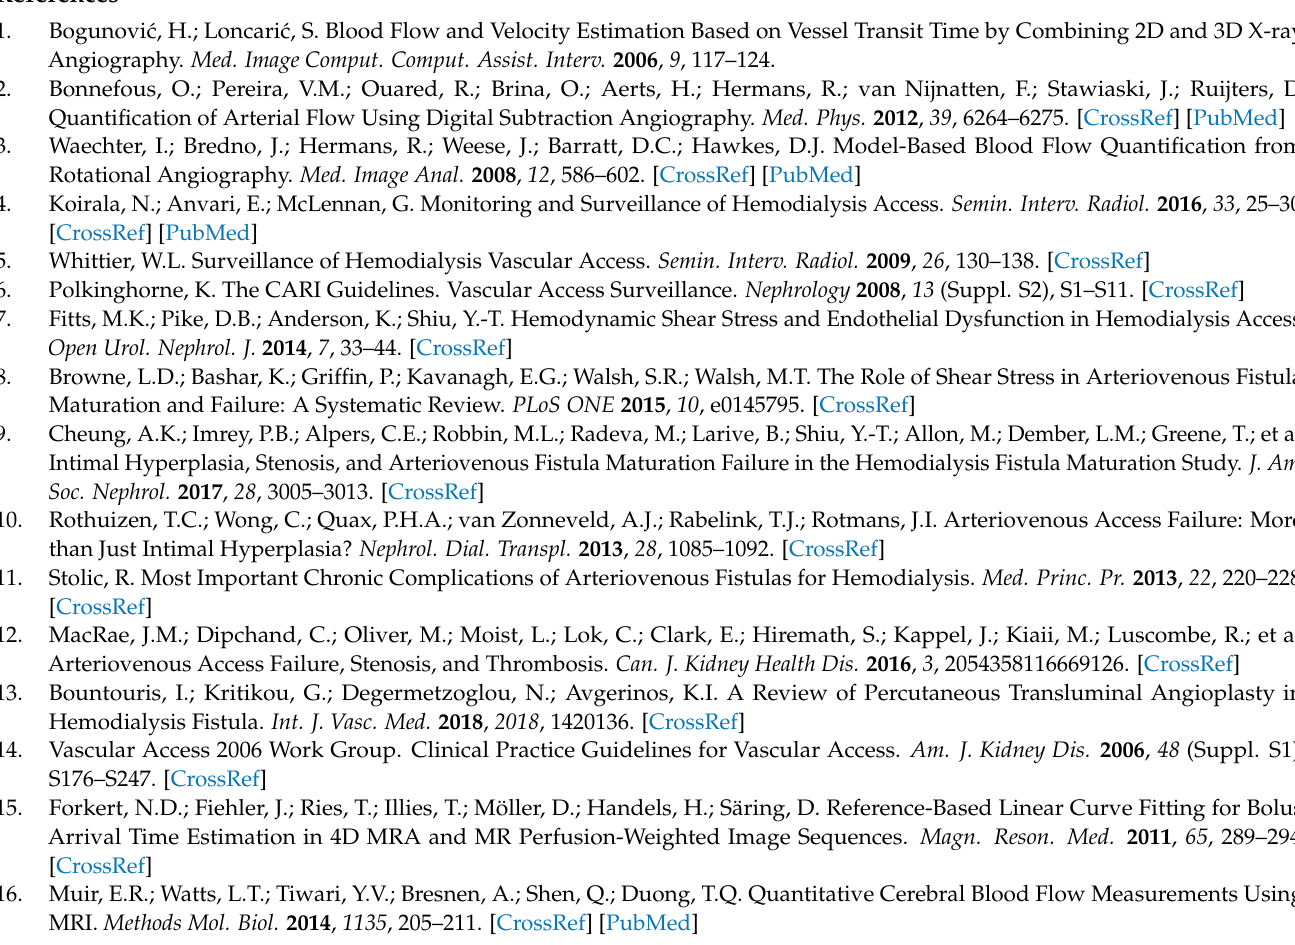
algorithm with DSA acquisition, Figure S3: Bland-Altman plots for fluoroscopic imaging, Figure S4: Radiation burden for DSA acquisition and fluoroscopic